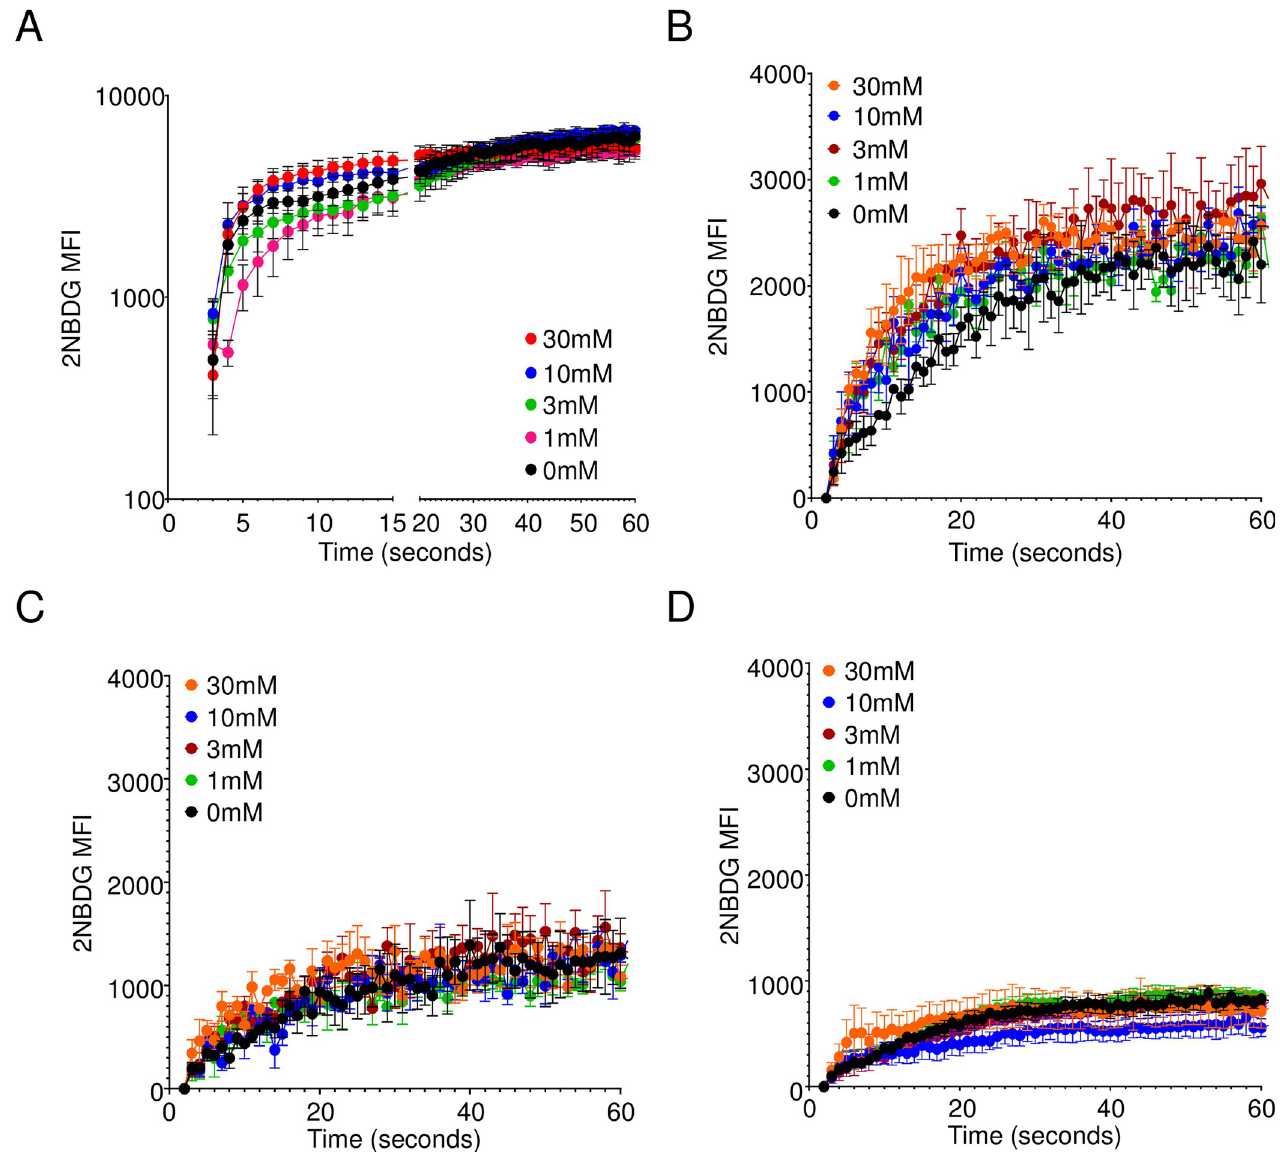
Fig 7. 2NBDG uptake in cells is independent of competing glucose. (A) 5TGM1 cells were resuspended in either glucose-free RPMI or RPMI with D-glucose at the mentioned final concentrations. 2NBDG was added at a final concentration of 60 μ M and intensity monitored immediately after addition by flow cytometry. (B-D) CD138+ enriched spleen cells were resuspended in glucose-free RPMI or RPMI with D-glucose at the specified concentrations. 2NBDG was added and intensity monitored immediately by flow cytometry. 2NBDG intensity in (B) plasma cells (CD138+ B220+/-), (C) B cells (CD138- B220+), and (D) unenriched total spleen cells are shown for the mentioned time points. Mean +/- SEM shown for each group for the indicated time points. Pooled data from three independent experiments each.